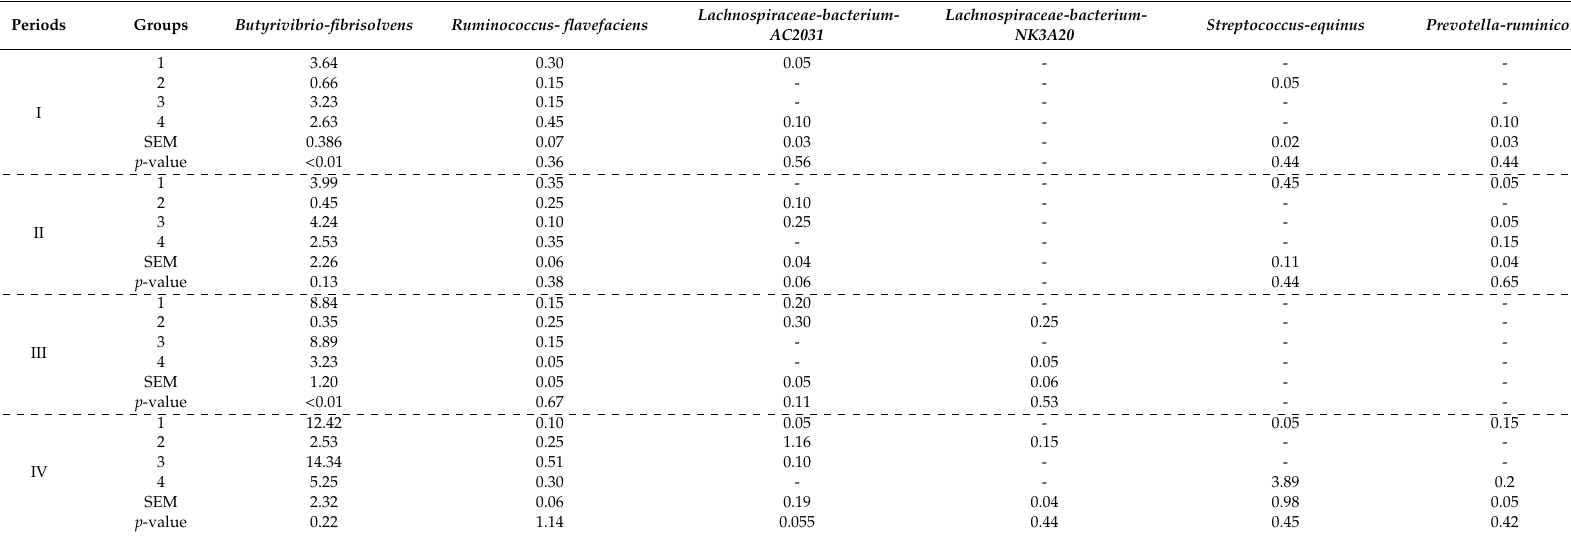
Table 3. E ff ects of dietary NFC / NDF ratio change on the relative abundance of cellulose-degrading bacteria, semi-cellulose-degrading bacteria, and starch-degrading bacteria in Karakul